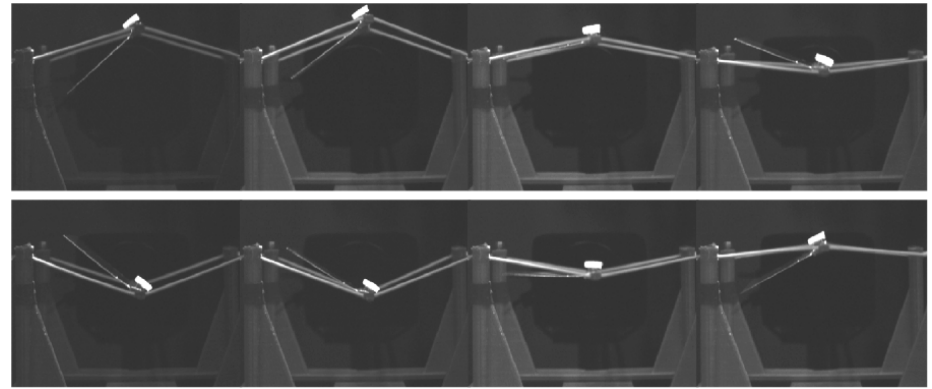
Figure 2. Some snapshots showing the wing motion under the wind action. In this case, chord = 40 mm, span = 60 mm, U = 3.8 m/s.